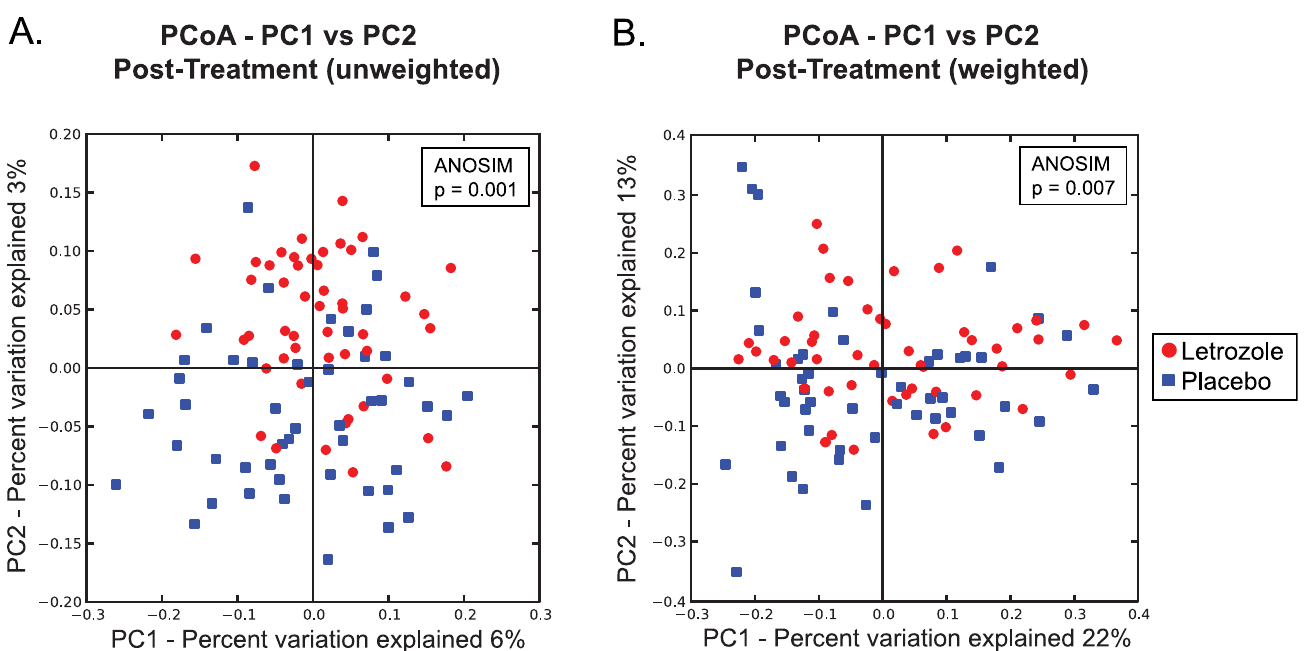
Fig 3. Letrozole treatment results in a significant shift in gut microbiome beta diversity. Principle Coordinates Analysis based on unweighted (A) and weighted (B) UniFrac distances. Comparison of samples collected post-treatment from placebo and letrozole treated